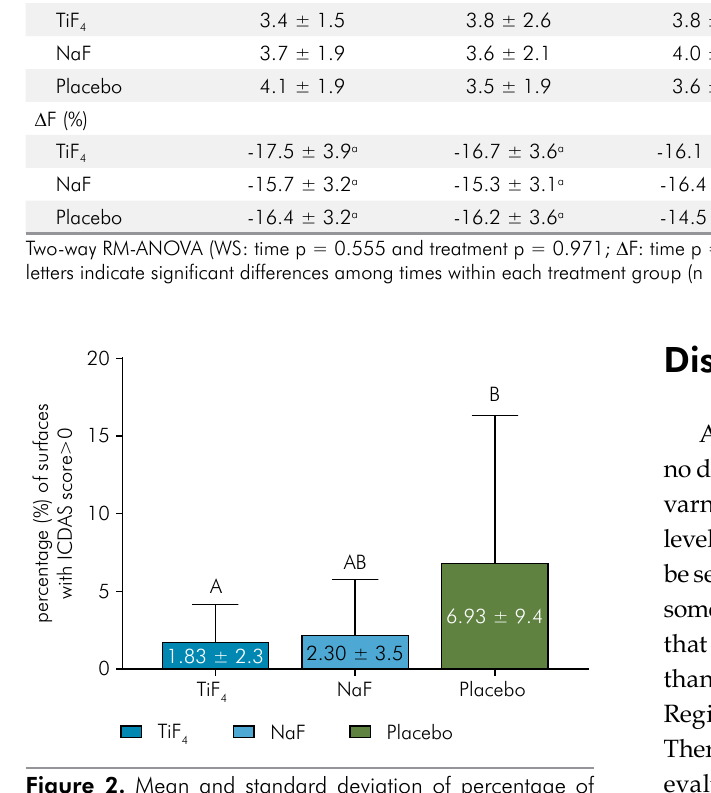
Figure 2. Mean and standard deviation of percentage of dental surfaces per child who previously had an ICDAS score of 0 that developed caries lesions at the end of study (18 months).